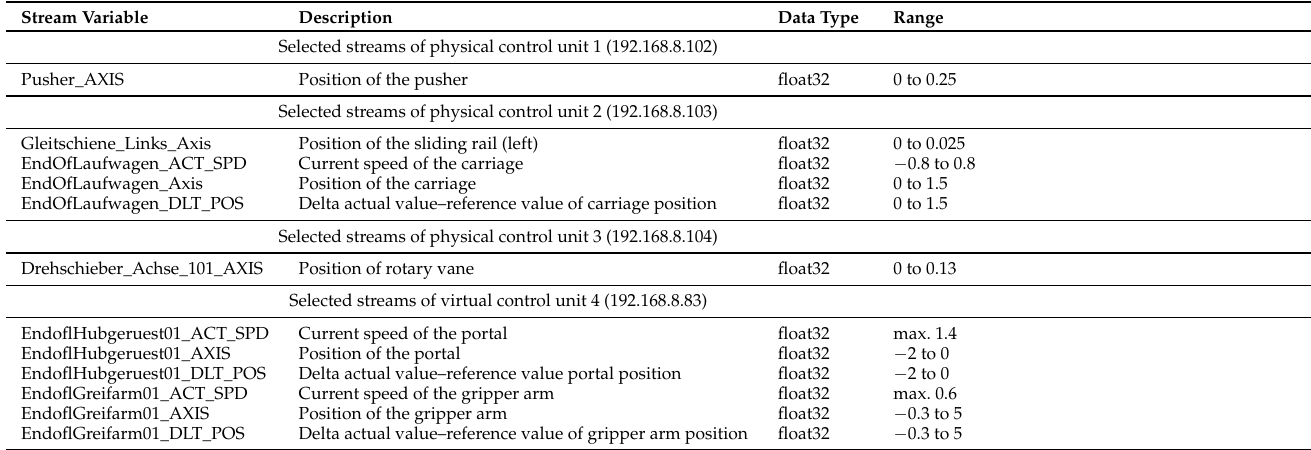
Table 3. Considered data streams generated by the simulation for stream processing.